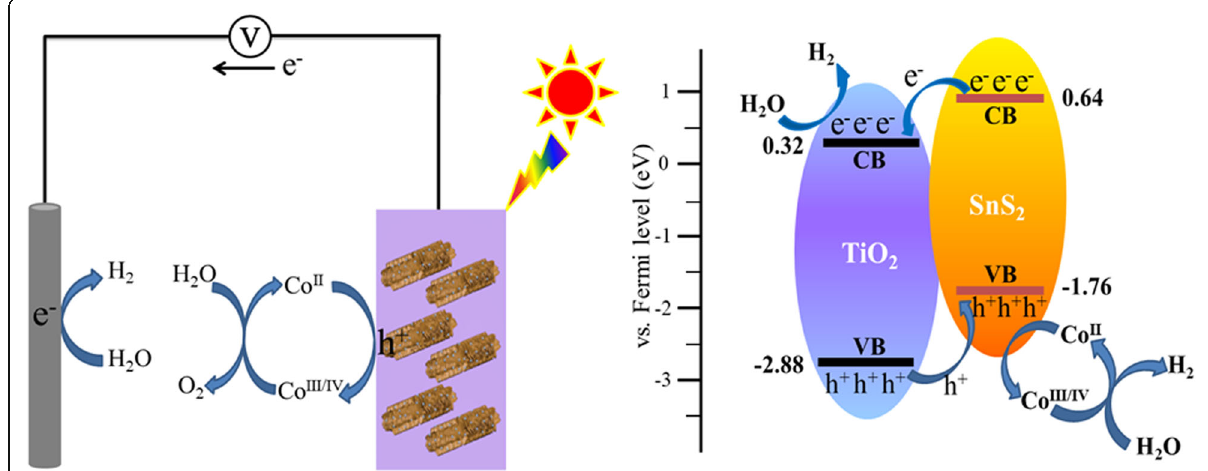
Fig. 6 Schematic illustration of device configuration and proposed energy band structure mechanism of TiO 2 /SnS 2 /CoO x